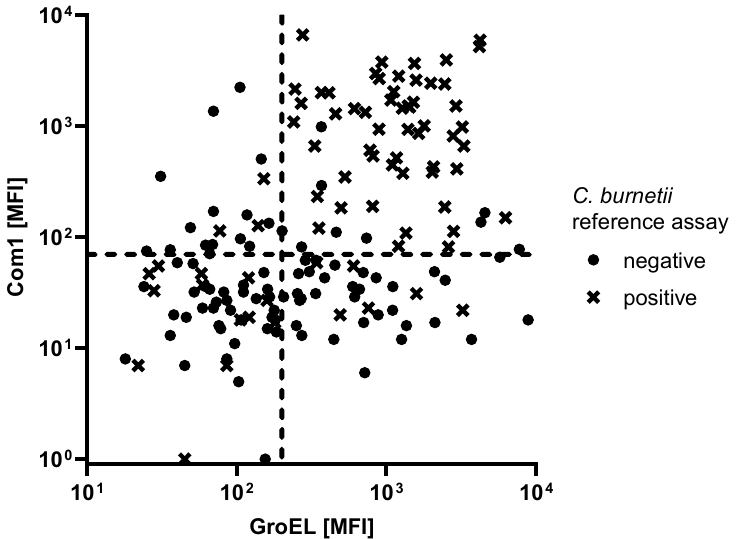
Figure 2. Antibody responses against the C. burnetii antigens Com1 and GroEL measured in 76 C. burnetii seropositive and 91 seronegative patients. Dashed lines (x = 200 MFI; y = 70 MFI) indicate the respective cutoffs to obtain a specificity of 90% and a combined sensitivity of 71%.